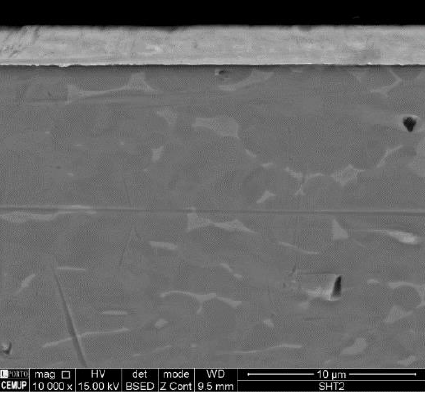
Figure 3. Cross-section SEM backscattered electron (BSE) image of a Ni/Ti multilayer thin film (W interlayer) with 12 nm period after heat treatment (HT) at 600 °C.